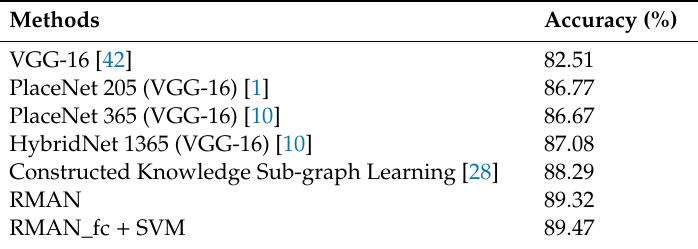
Table 1. Comparison of RMAN model with other methods on Scene